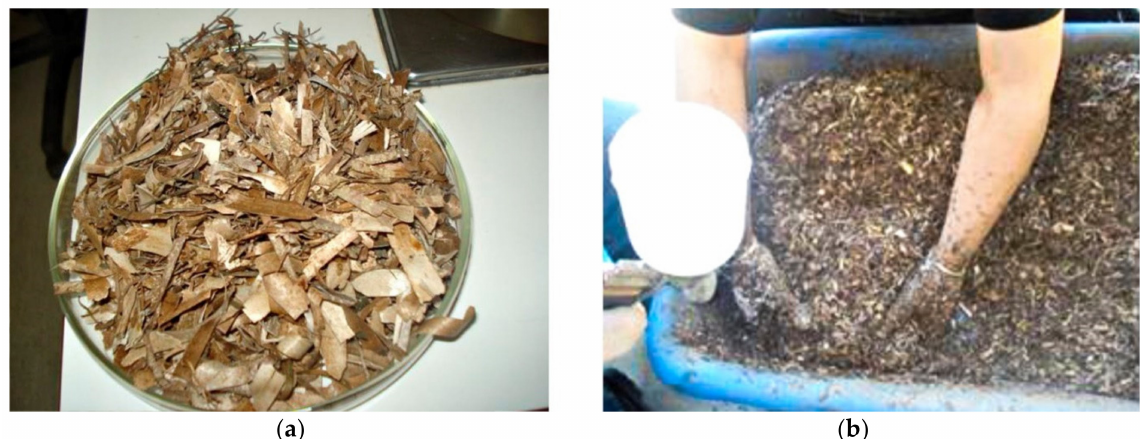
Figure 1. Possidonia oceanica (PO) leaves as collected ( a ) and after drying ( b ).